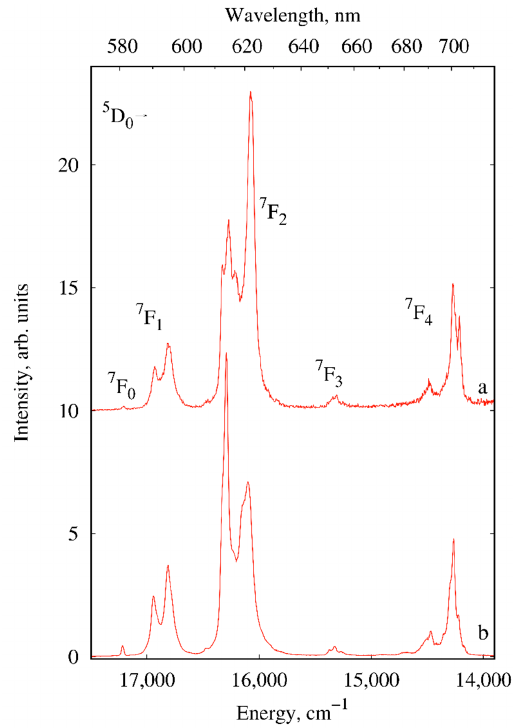
Figure 5. Luminescence spectra of I ( a ) and VI ( b ) (solid samples, λ ex = 280 nm, T = 300 K).